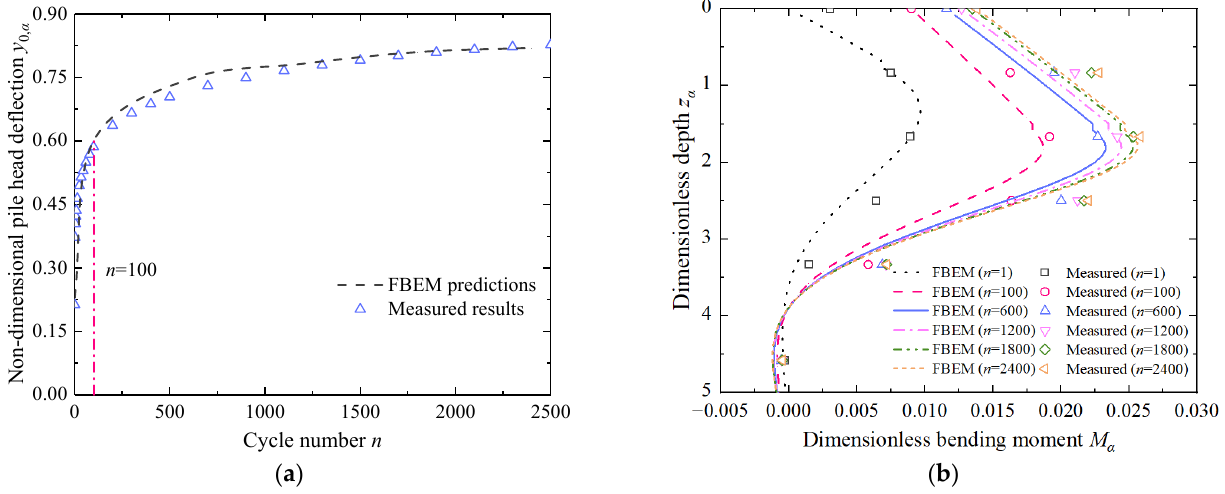
Figure 16. Comparisons of cyclic lateral responses predicted by FBEM and those measured by experiments in test C2. ( a ) pile head deflection versus cycle number; ( b ) bending moment profile.